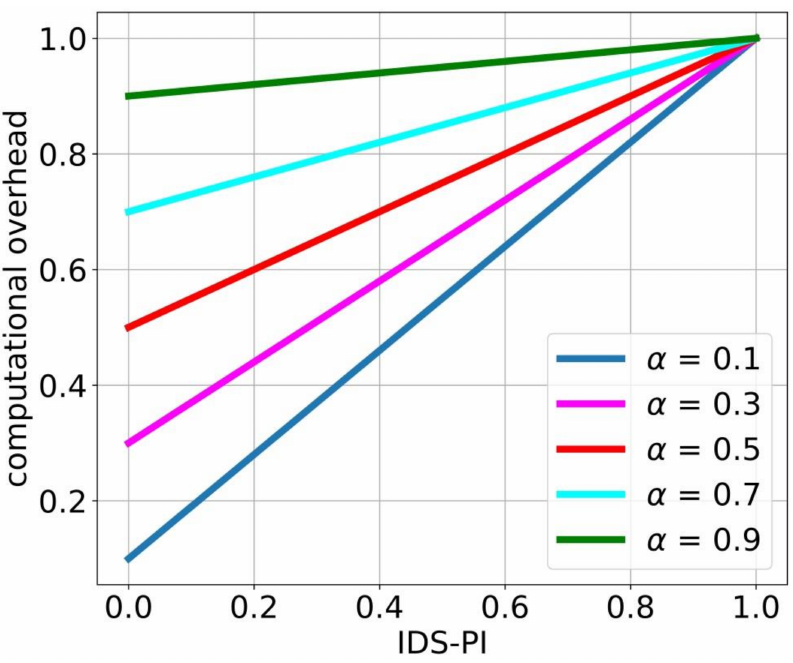
Figure 3. The computational overhead is acceptable if its value lies above the corresponding